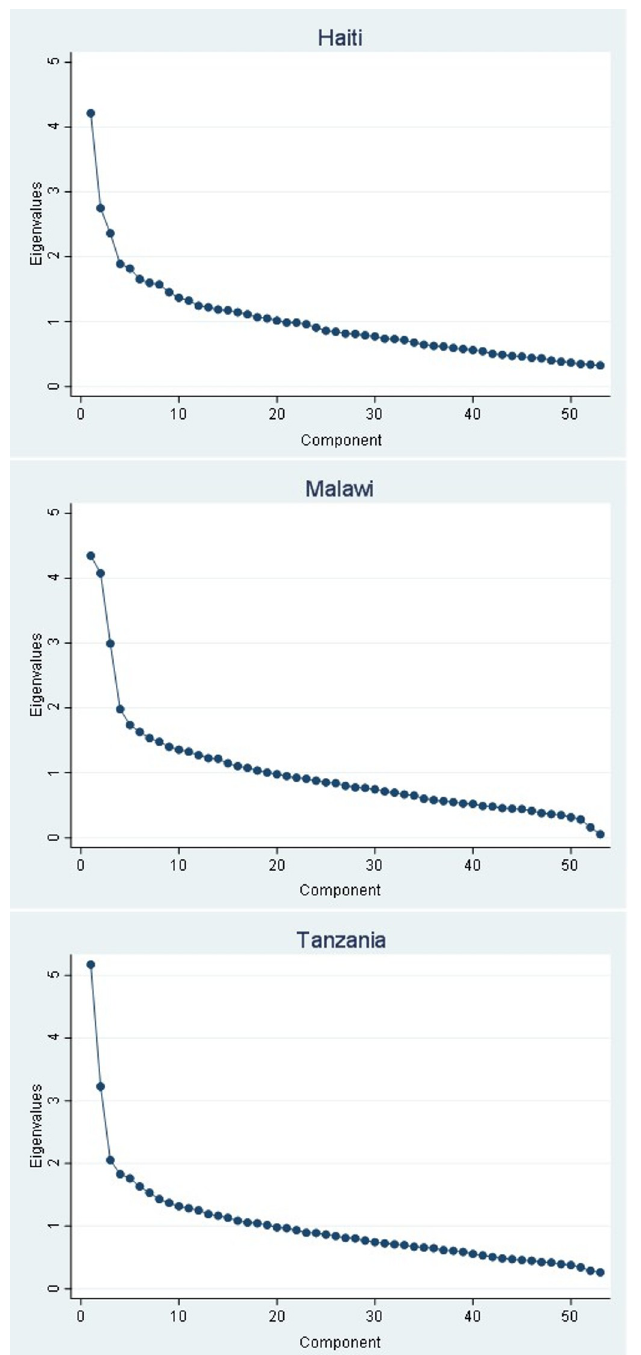
Fig 2. Scree plots of the eigenvalues after